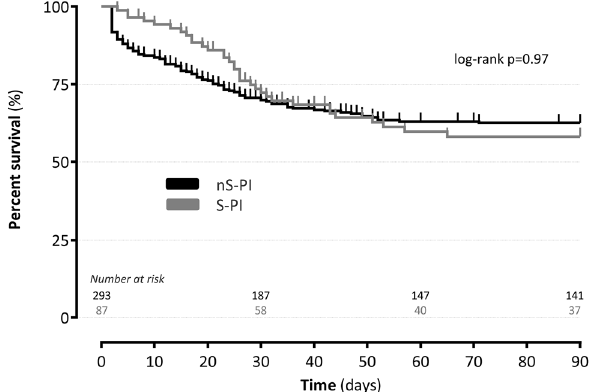
Figure 1. Kaplan–Meier survival estimates of the S-HAI and nS-HAI groups during the first 90 postoperative days. nS-HAI infection without peritoneal staphylococci cultures, S-HAI infection with staphylococci peritoneal